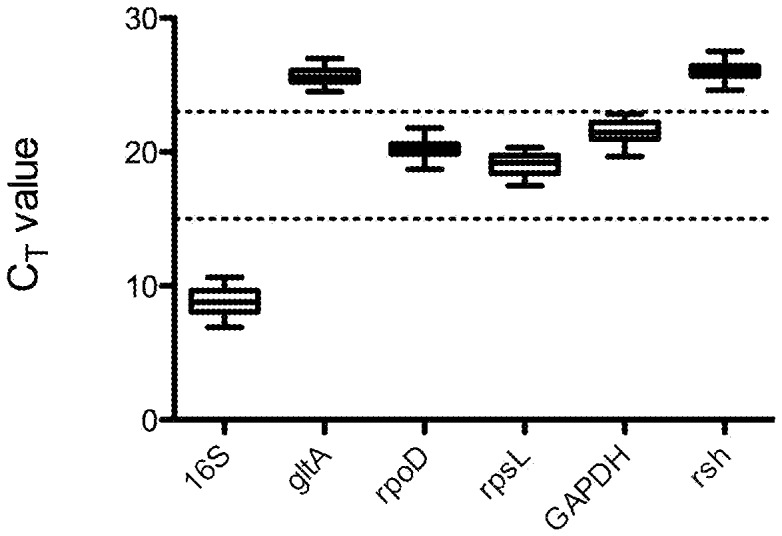
Real-time PCR CT values in the samples collected.The distribution of the expression levels of candidate reference genes is shown by the median (lines), the lower and upper quartiles (boxes), and ranges (whiskers) (n = 20). The genes were divided into three groups by the arbitrary lines at CT 15 and 23, on the basis of their different expression levels.